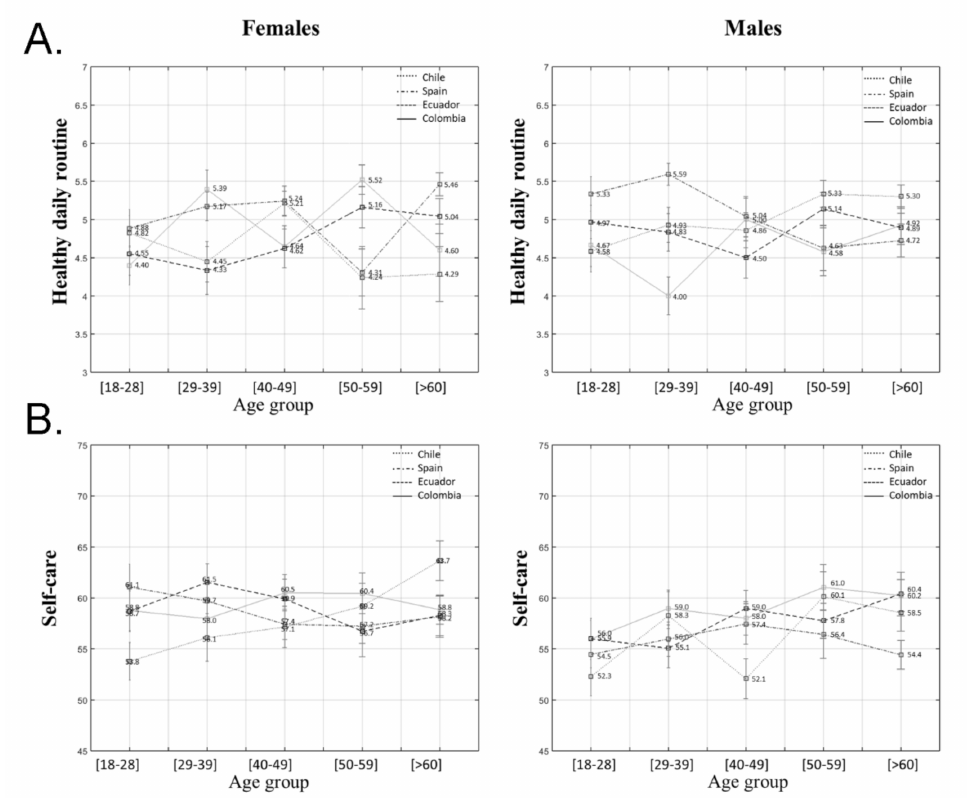
Figure 2. Values for ( A ) healthy daily routine, and ( B ) self-care differentiated by gender, age group, and